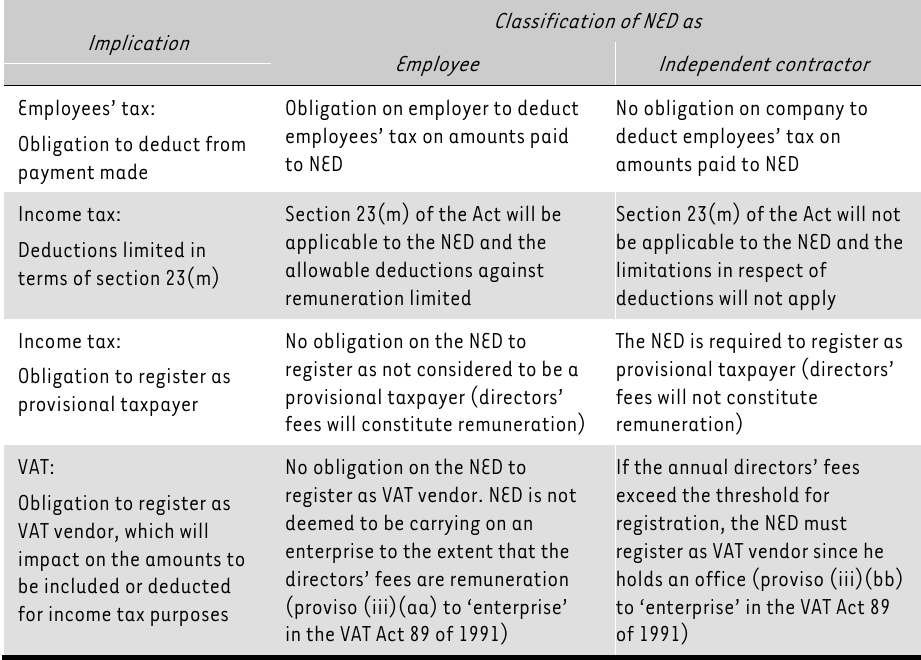
The implications of classification Classification of NED as Implication Employee Independent